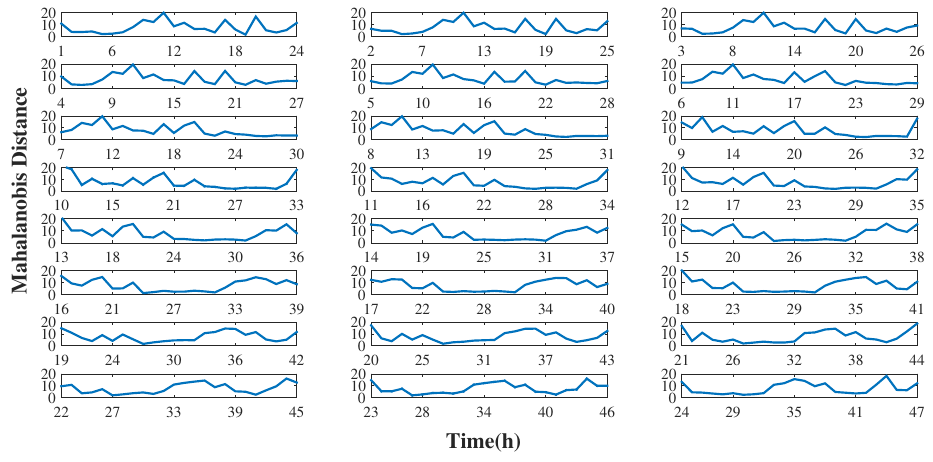
Figure 4. Online monitoring - Day #1 and Day